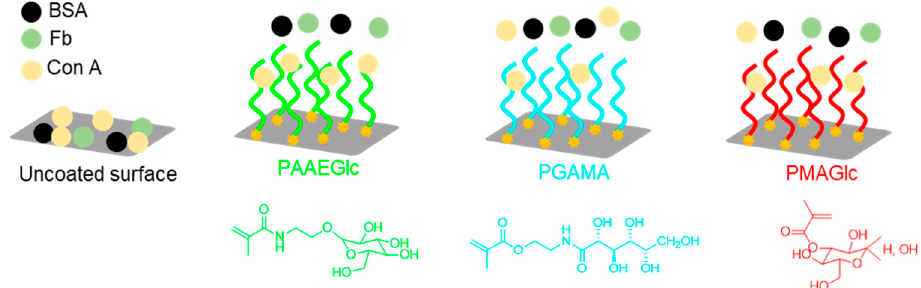
Figure 5. Specific protein interaction of BSA, Fb, and Con A with different glucose-based brushes.